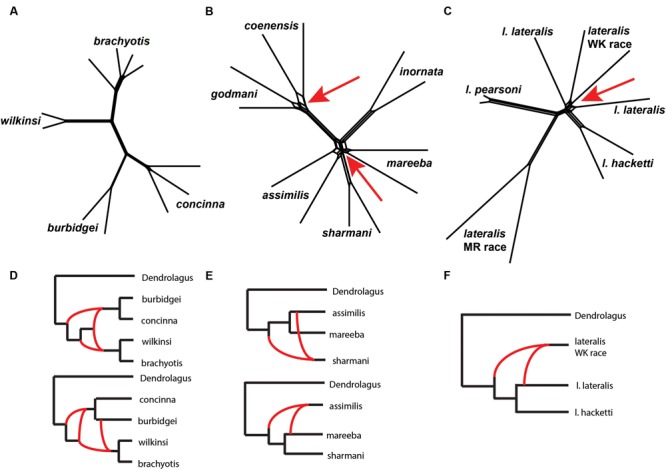
(A–C) A phylogenetic network analysis of the chromosomal groups (A)
brachyotis, (B)
lateralis, and (C)
penicillata estimated using a distance based approach in SplitsTree (Neighbor-Net). The red arrows highlight regions on the network where reticulation is inferred. (D–F) Model based analysis of reticulate evolutionary history based on analysis of 0–3 reticulations. The lowest log likelihood results are shown for each (D)
brachyotis, (E)
lateralis, and (F)
penicillata chromosomal groups using PhyloNet. Analysis was performed on a single individual for each taxon and two replicate analyses, each including one of the two independent samples per taxon. (D) The brachyotis group supported 2–3 reticulations and highlight reticulation involving ancestors in the brachyotis group. (E) The penicillata group analysis include a three species complex (P. assimilis, P. mareeba, and P. sharmani) and support a single reticulation model but alternate topologies and individuals involved in reticulation based on the individuals used in the analysis. (F) The lateralis group analyses included three taxa (P. l. lateralis, P. l. hacketti and P. l. West Kimberley race). The results were congruent in identifying a single reticulation model, which involved the P. lateralis West Kimberley race.